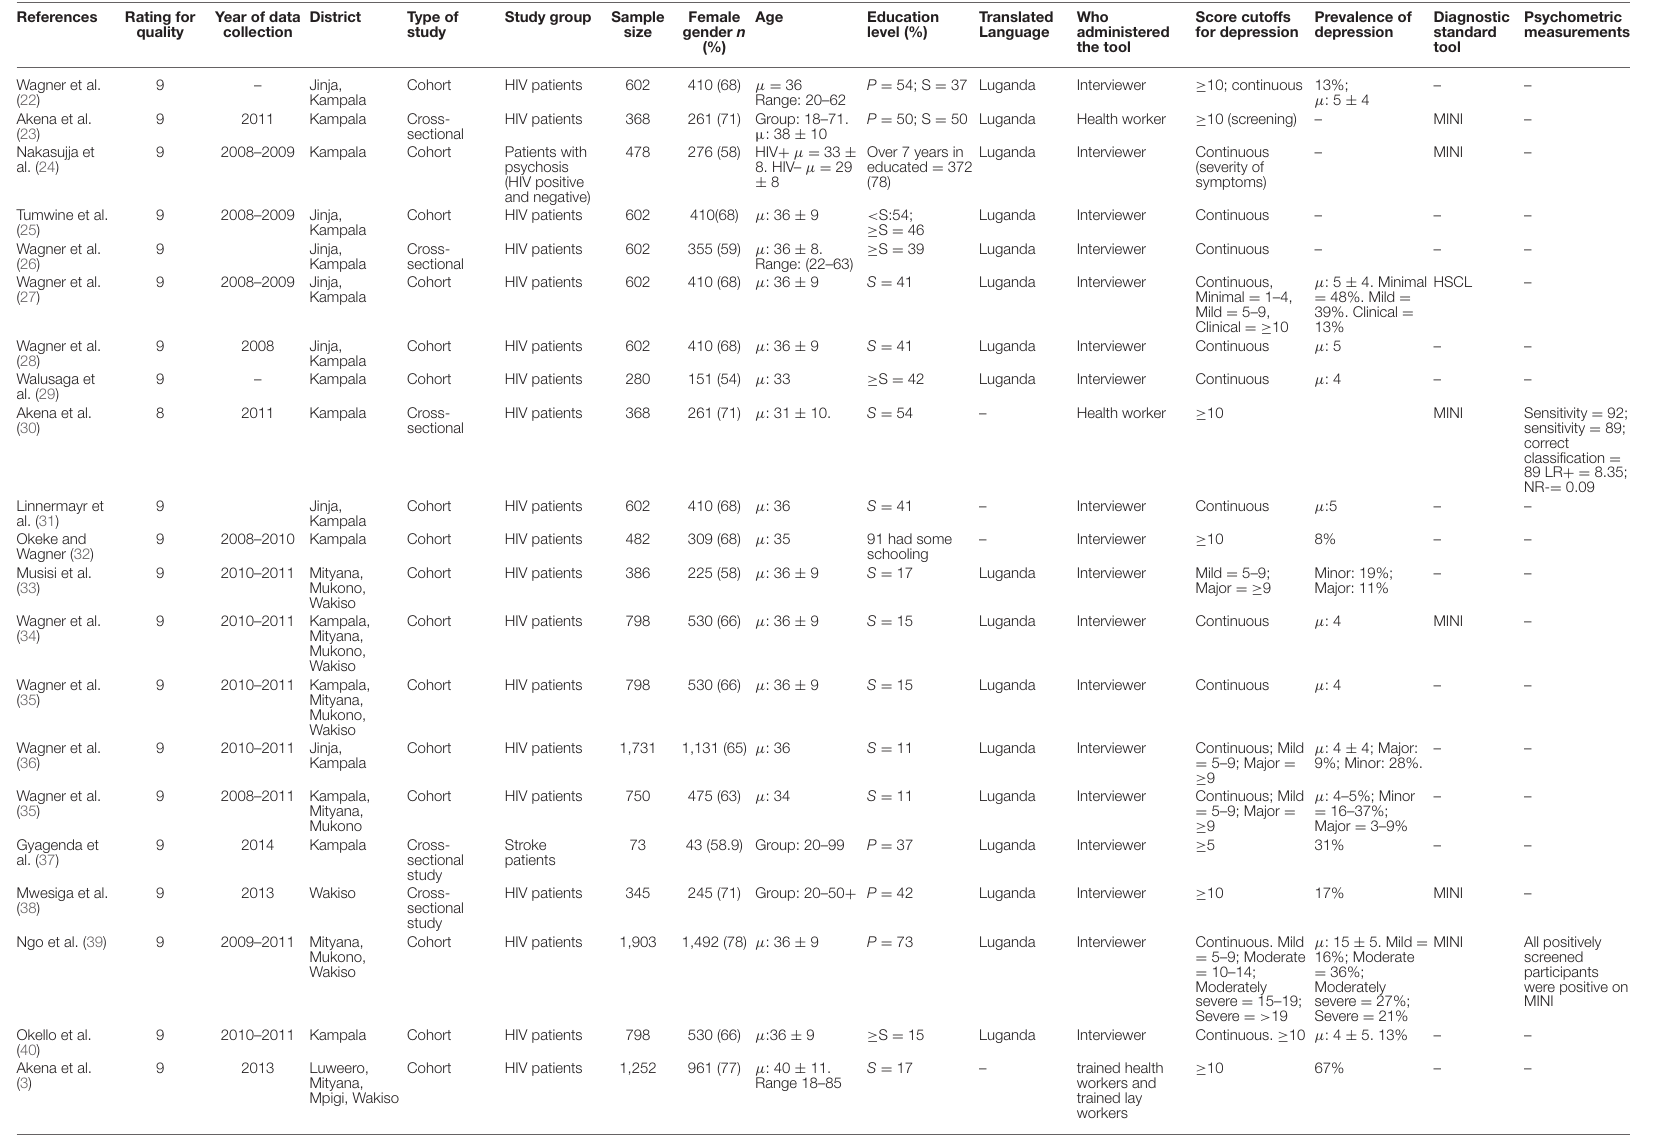
TABLE 1 | Characteristics of the included literatures in the present